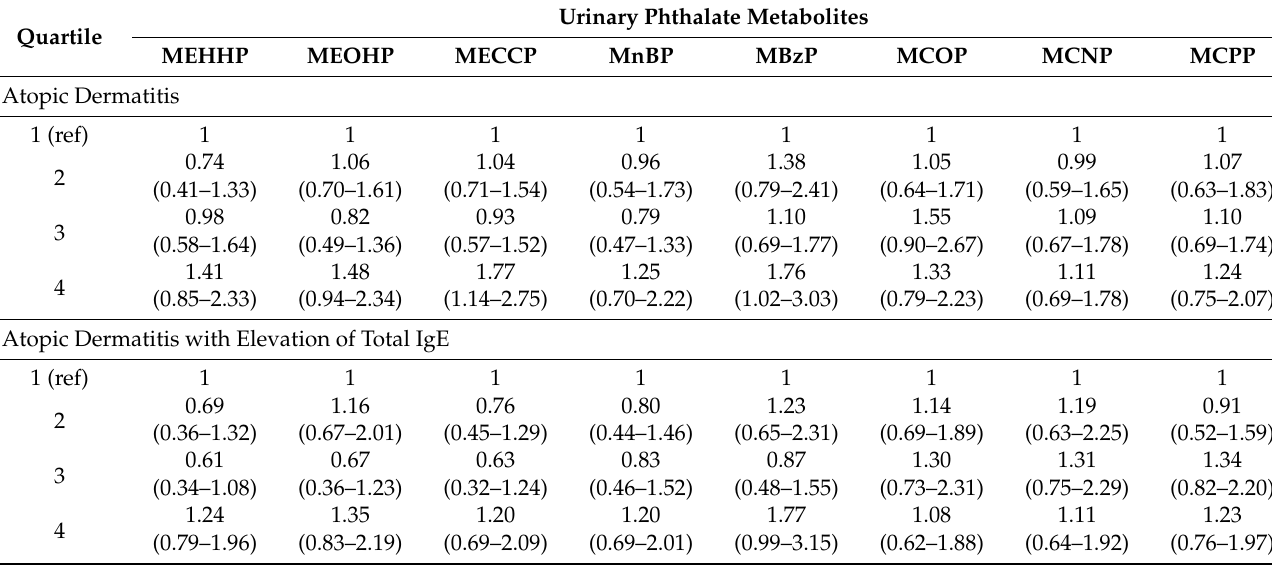
Table 4. Association (OR (95% CI)) between urinary concentration of phthalate metabolites and atopic dermatitis according to the presence of elevation of total IgE (Crude